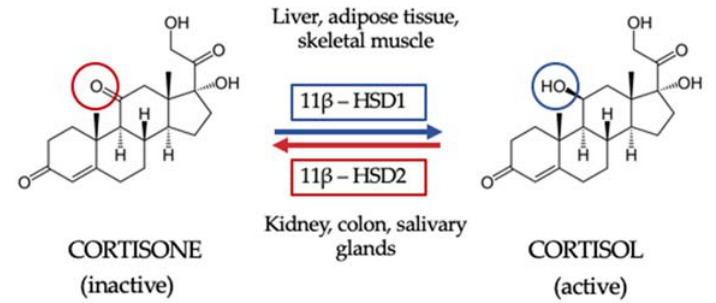
Figure 1. The 11 β hydroxysteroid dehydrogenase shuttle. The 11 β hydroxysteroid dehydrogenase type 1 isoform (11BHSD1) is expressed in key metabolic tissues such as the liver, adipose tissue and skeletal muscle, and its function is to convert inactive cortisone to active cortisol. The 11BHSD type 2 isoform (11HSD2) is expressed by kidney, colon and salivary glands and catalyzes the inactivation of cortisol to cortisone, thus not only protecting the mineralocorticoid receptor from the occupancy of cortisol but also providing the substrate for 11BHSD1 in peripheral tissue.